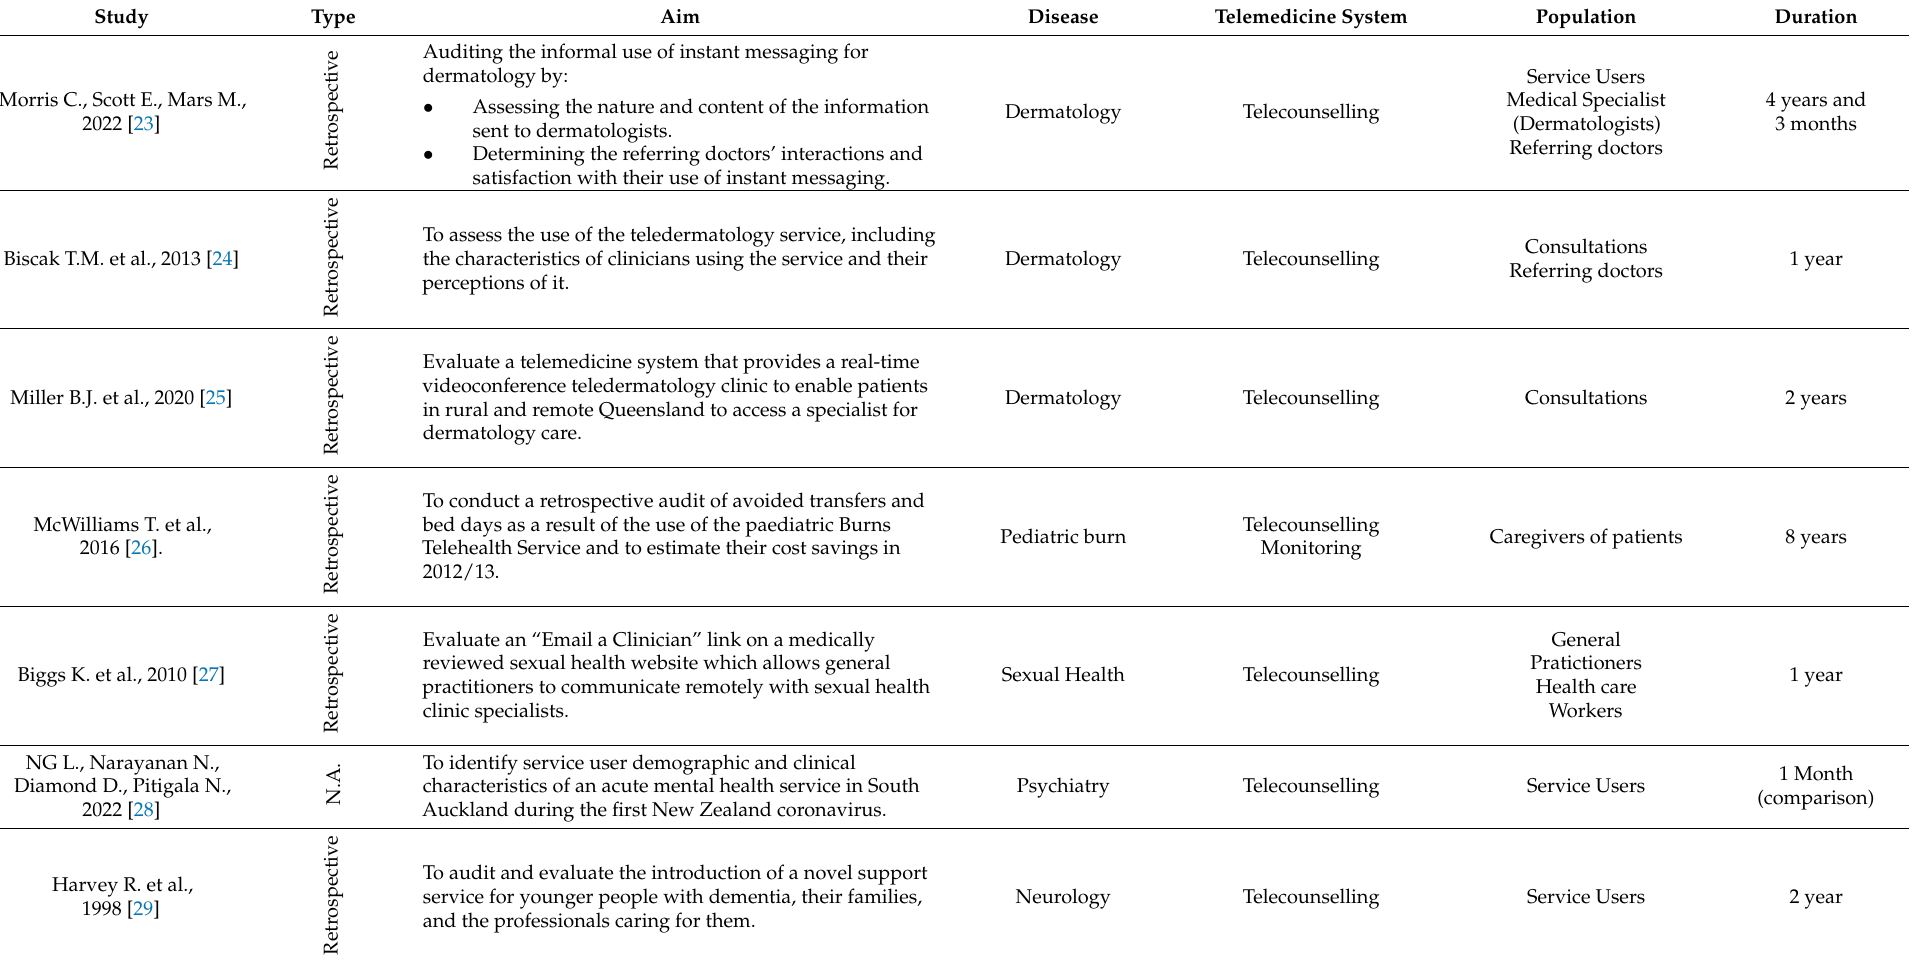
Table 1. Description of studies performed on a telemedicine